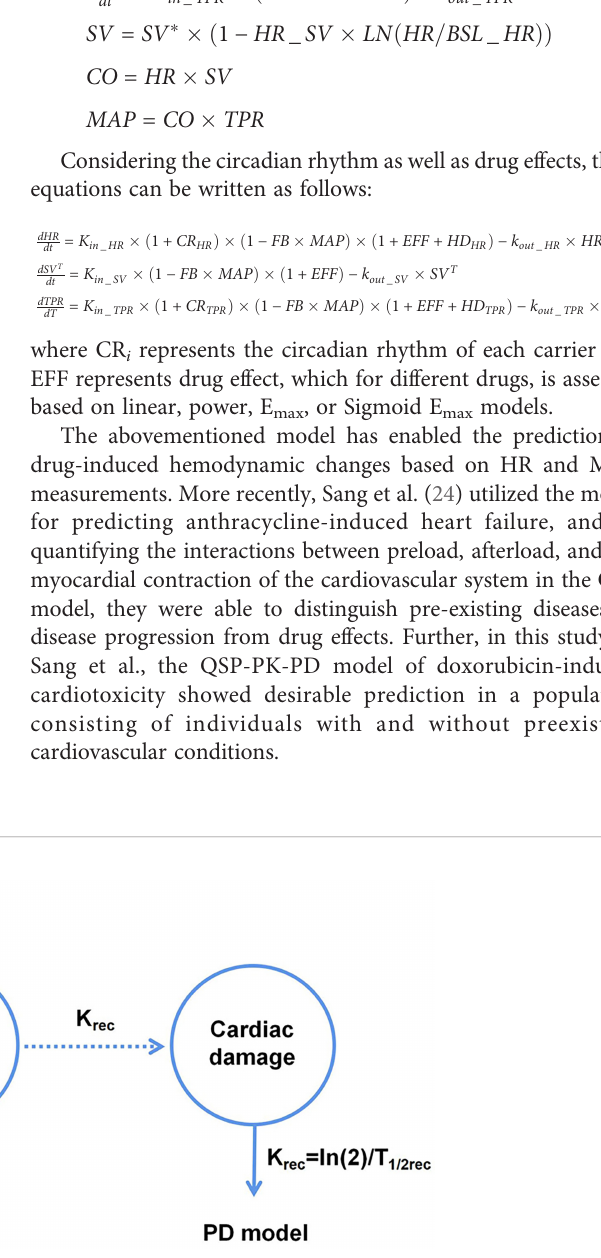
FIGURE 2 | Schematic representation of the PK-PD model corresponding to the relationship between the left ventricular ejection fraction and trastuzumab